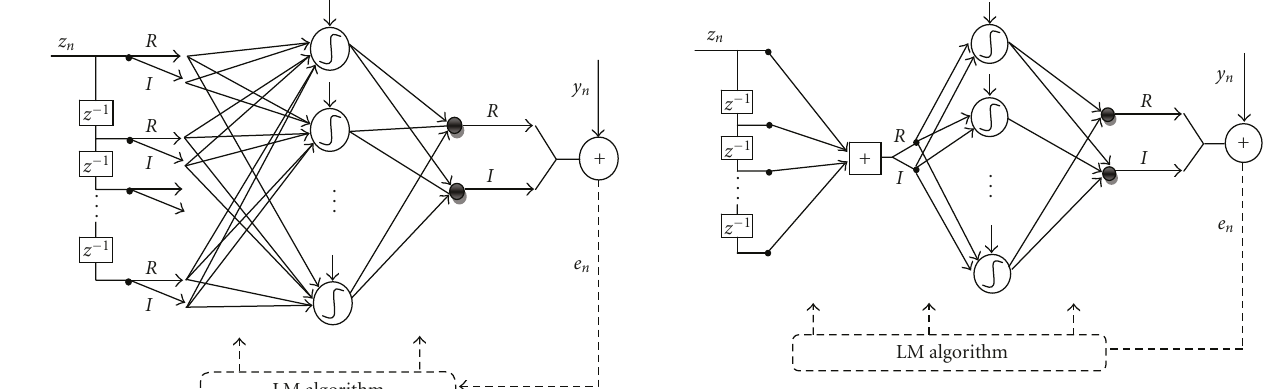
Figure 21: Linear network LN + nonlinear network NLN predis- torter structure.